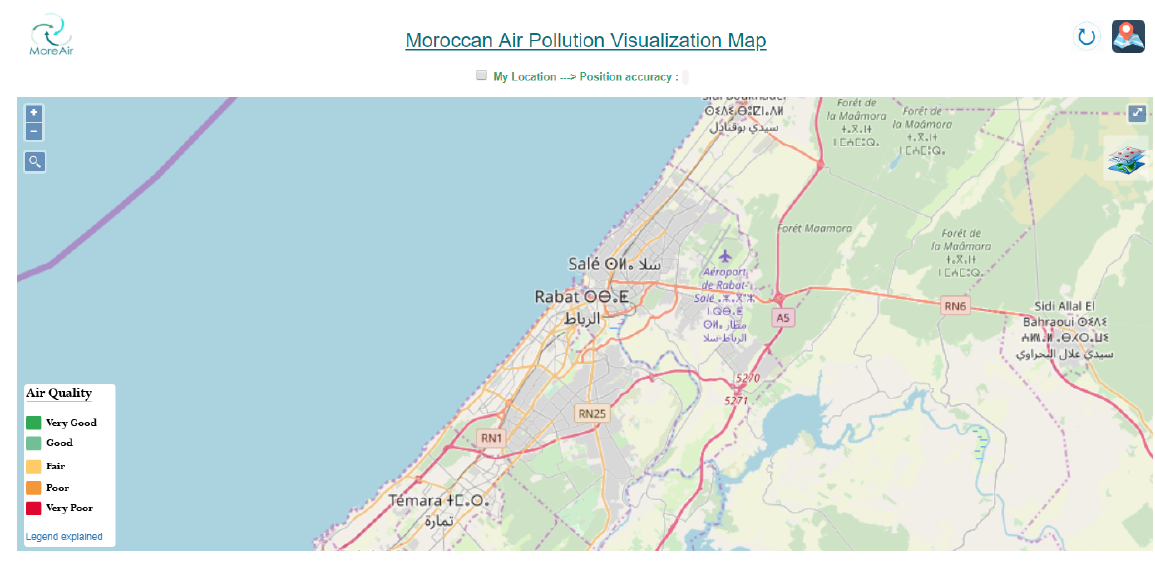
Figure 15. Moroccan Urban Air Quality